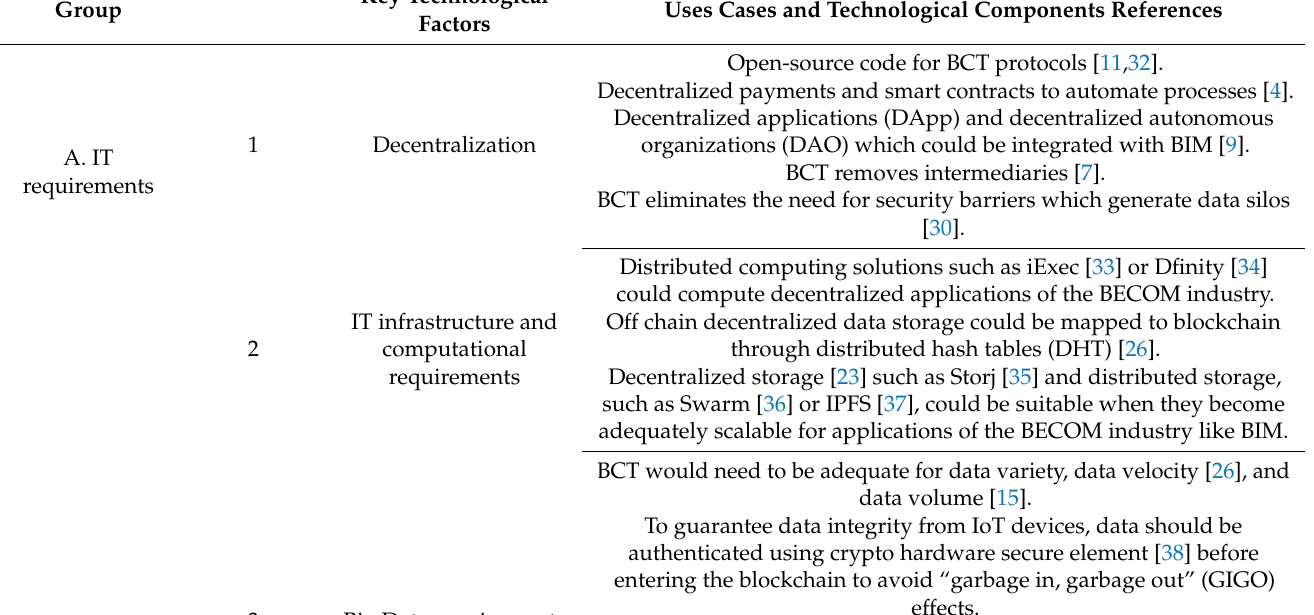
Table 2. Key technological factors affecting the adoption of blockchain technology in the BECOM industry.